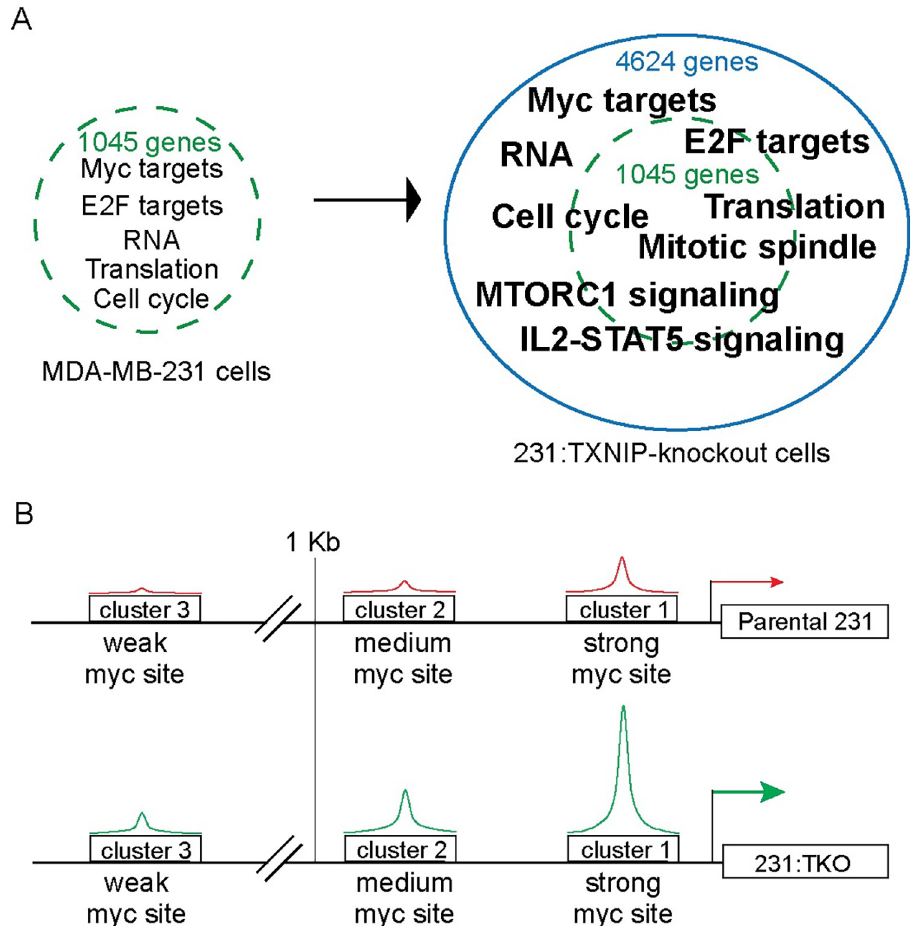
Fig 7. TXNIP is a repressor of Myc genomic binding and transcriptional activity. ( A ) Following TXNIP loss, the Myc-dependent transcriptome is expanded relative to that present in the parental MDA-MB-231 cells. Expansion in the 231:TKO cells does not dramatically alter the pathways regulated in the parental cells; rather, there are more genes in each pathway regulated following loss of TXNIP. ( B ) We assigned Myc binding to 3 clusters based on whether they showed strong (cluster 1), medium (cluster 2), or weak (cluster 3) Myc binding in the parental 231 cells. The majority of sites in clusters 1 and 2 are located within 1 kb of the TSS, whereas the majority of the sites in cluster 3 are more distal from the TSS and likely represent distal enhancers. TKO, TXNIP-knockout; TSS, transcriptional start site; TXNIP, thioredoxin interacting